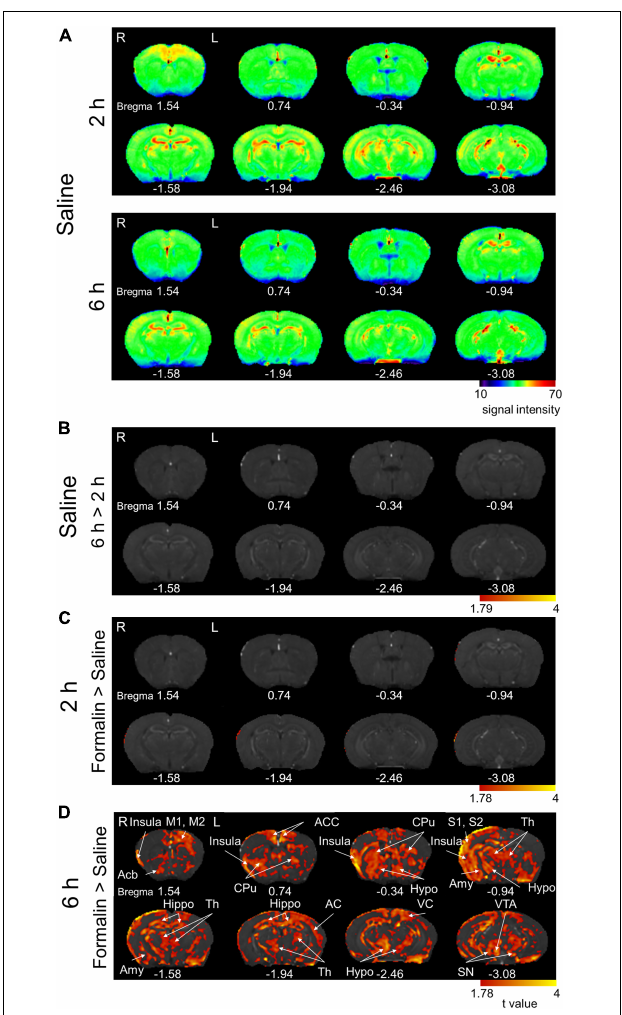
FIGURE 6 | Comparison of the manganese accumulation in the brain between formalin-treated and saline-treated groups. (A) Color map display of averaged T1-weighted images in the [2 h Saline] and [6 h Saline] groups. R, the right side; L, the left side (for all panels in this figure). The numbers below the images indicate the anterior-posterior coordinate from bregma. The color bar represents the normalized signal intensity. (B) Statistical comparisons of the signal intensity between [2 h Saline] and [6 h Saline] ( P < 0.05, cluster-wise FDR corrected). The color bar indicates the t -value. (C) Comparisons of the signal intensity between [2 h Formalin] and [2 h Saline] shown as t -value plots ( P < 0.05, cluster-wise FDR corrected). The color bar indicates the t -value. (D) Comparisons of the signal intensity between [6 h Formalin] and [6 h Saline] shown as t -value plots ( P < 0.05, cluster-wise FDR corrected). Insula, insular cortex; Acb, nucleus accumbens; M1/2, primary/secondary motor cortex; ACC, anterior cingulate cortex; CPu, caudate putamen; S1/2, primary/secondary somatosensory cortex; Th, thalamus; Amy, Amygdala; Hippo, Hippocampus; AC, auditory cortex; Hypo, hypothalamus; VC, visual cortex; VTA, ventral tegmental area; SN, substantia nigra. R, the right side; L, the left side. The color bar shows the t -value.